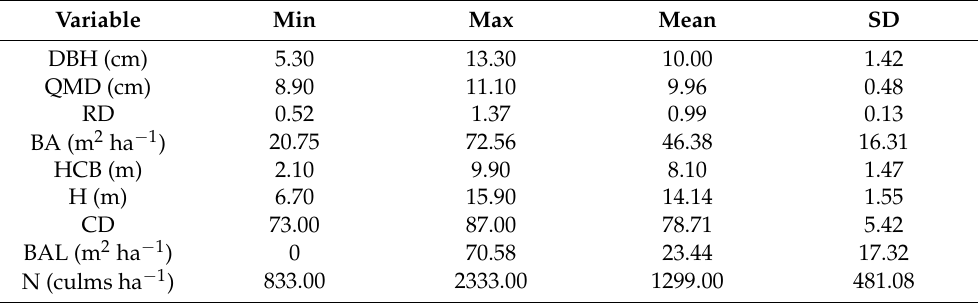
Table 1. Summary statistics of measurements of bamboo variables. Height to crown base (HCB), diameter at breast height (DBH), quadratic mean DBH (QMD), basal area (BA), relative diameter (ratio of DBH of individual to QMD; RD), base area per hectare (BA), bamboo height (H), canopy density (CD), total basal area of all bamboos with diameter larger than that of the subject bamboo (BAL), Number of culms per hectare (N), and standard deviation (SD). Variable Min Max DBH (cm)